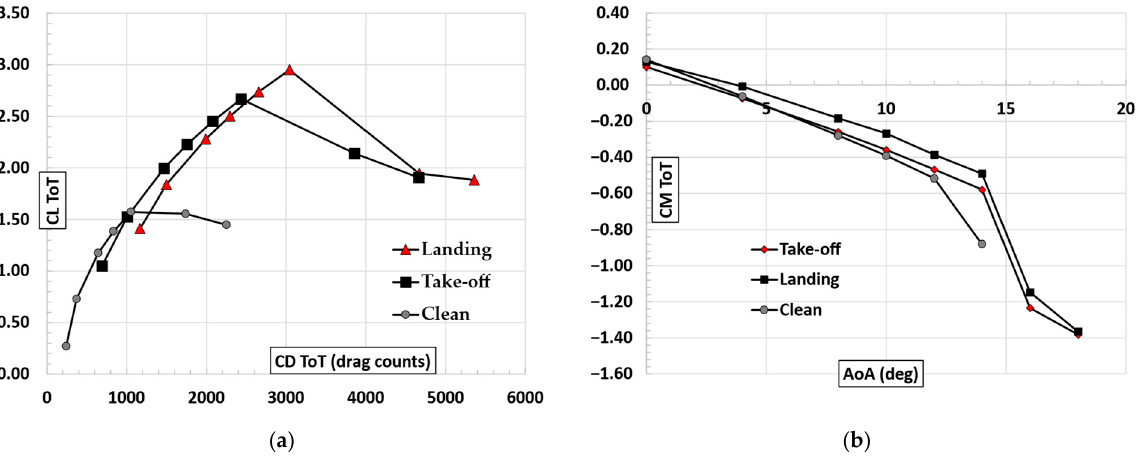
Figure 20. Drag and pitching moment curves, take-off and landing condition, M = 0.15, Re = 5.7 × 10 6 . ( a ) Drag polar (drag expressed in counts). ( b ) Pitching moment coefficient w.r.t. CG pos. (31% mac). Table 13. Numerical results for low-speed conditions, untrimmed maximum lift coefficient, mo- ment coefficient calculated w.r.t. CG pos. (31% mac), M = 0.15, Re = 5.7 × 10 6 .